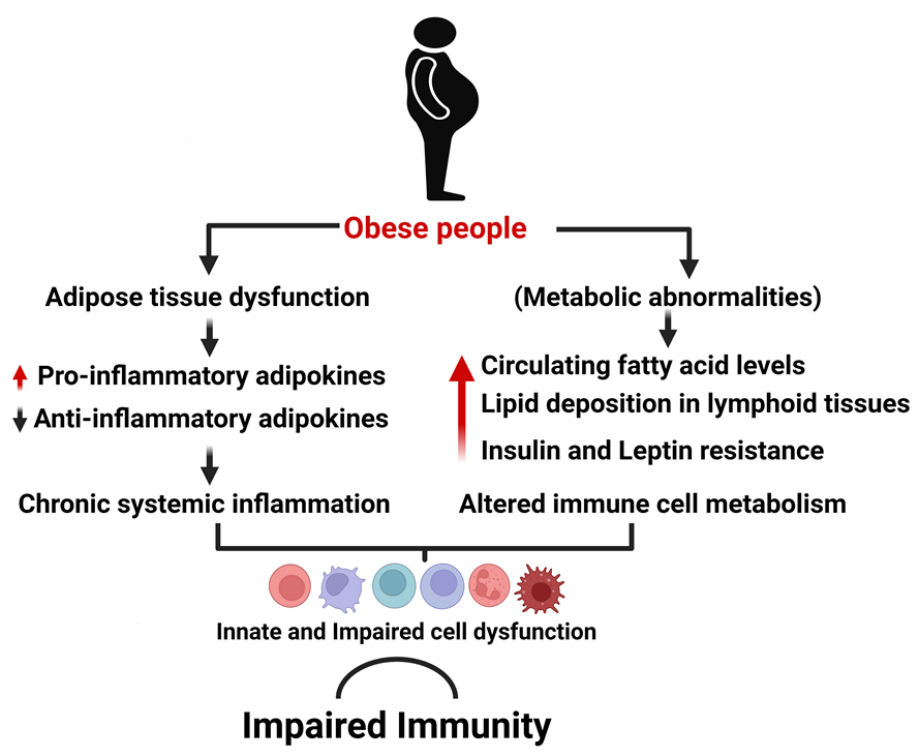
Figure 1. Obesity induced impairment of immune defense. Excess body fat causes metabolic abnor- malities that result in chronic systemic inflammation and impaired immune cell metabolism. As a result, innate and adaptive immune cells malfunction, resulting in a weakened immunological re- sponse to